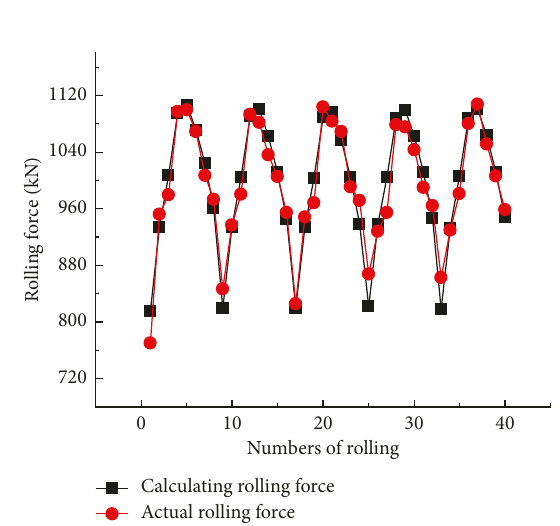
Figure 4: Comparison of rolling force obtained by metal flow model and actual rolling